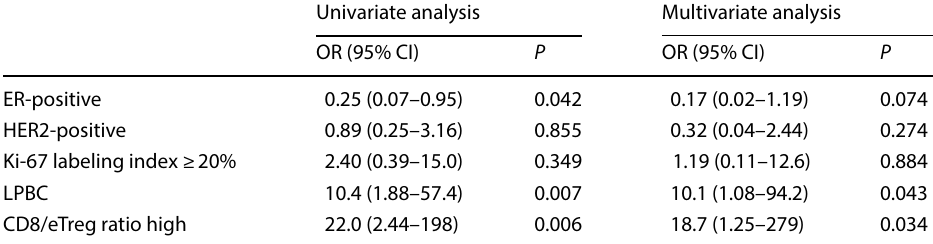
Table 4 Logistic regression analysis for predicting pathological complete